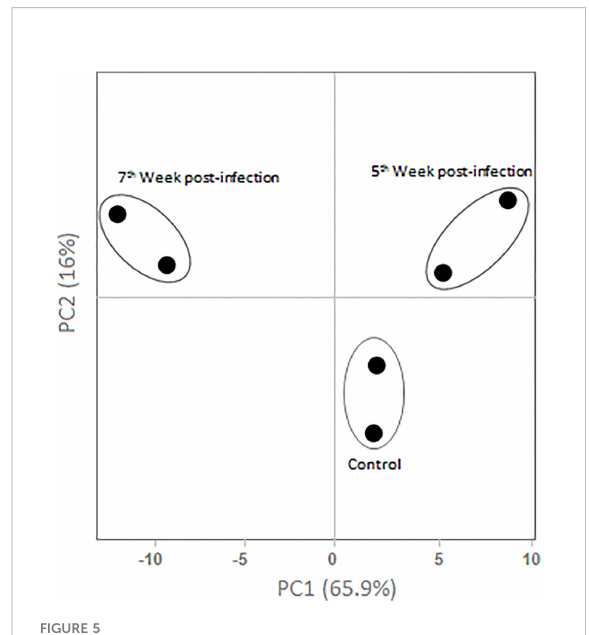
FIGURE 5 Principal Component Analysis. Unit variance scaling was applied, the standard variation with imputation was used to calculate principal components. Axes demonstrates principal component 1 and principal component 2 showing 65.9% and 16% of the total variance,